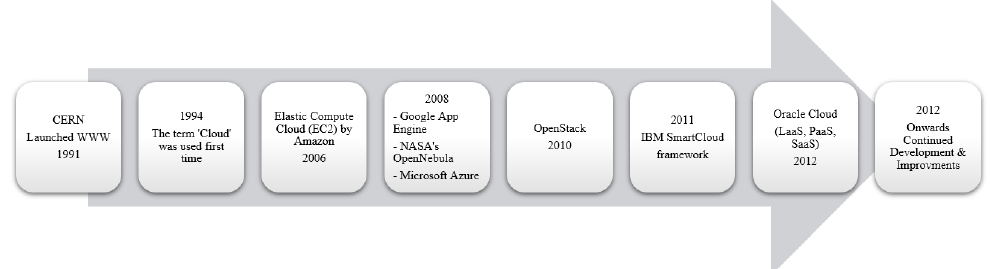
Figure 3. Cloud computing